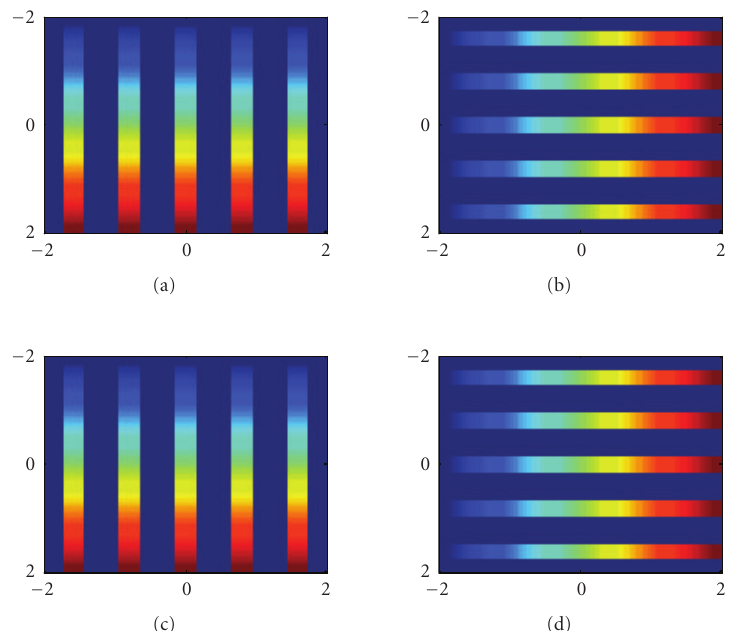
Figure 4: Distributions of phase gradients.The phase object is specified in (24) with S x = 5 and S y = 5. (a) The true x -gradient; (c) The measured x -gradient by phase stepping measurement. (b) and (d) are for the y -gradient. The spatial unit is μ m.